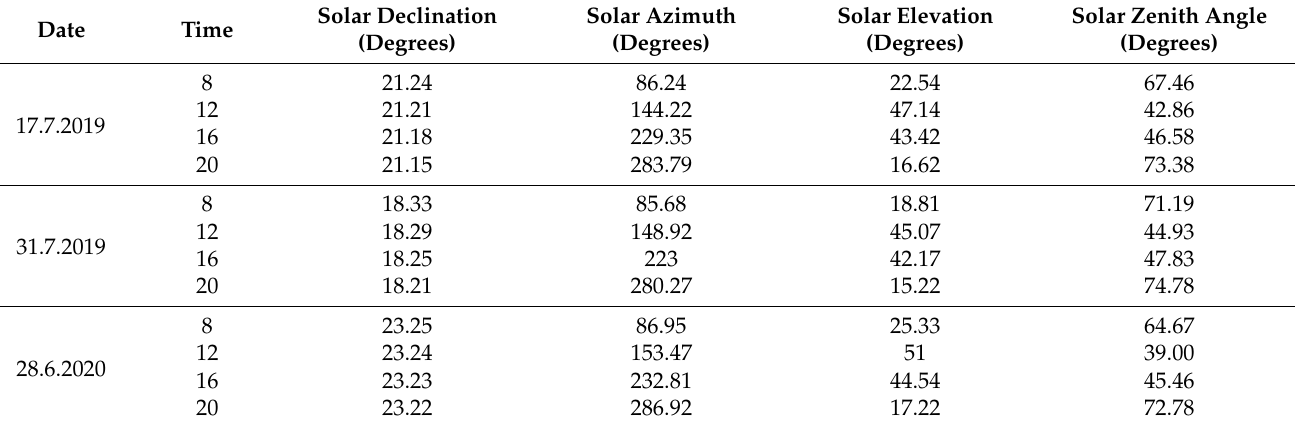
Table A2. Solar position values for different flight days. Values were calculated using the NOAA